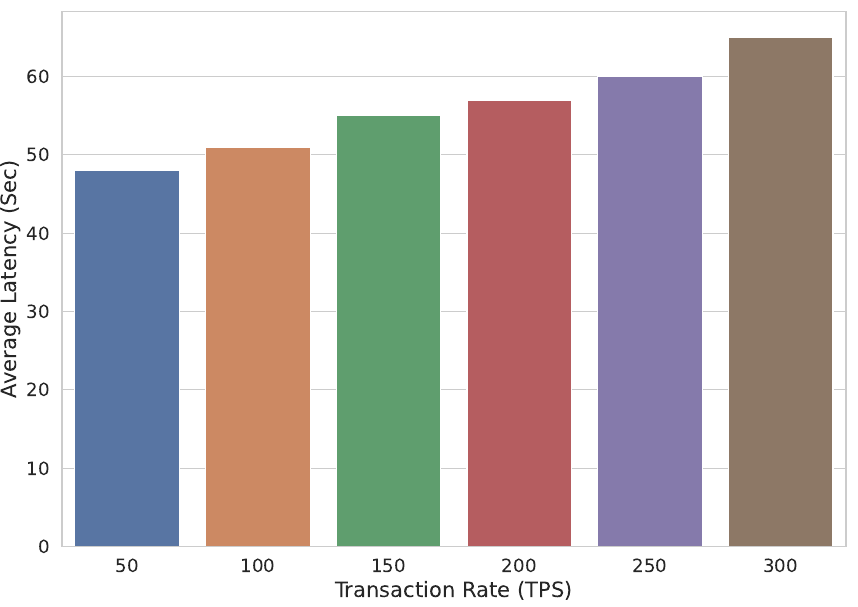
Figure 15. Average latency with varying transaction rate.